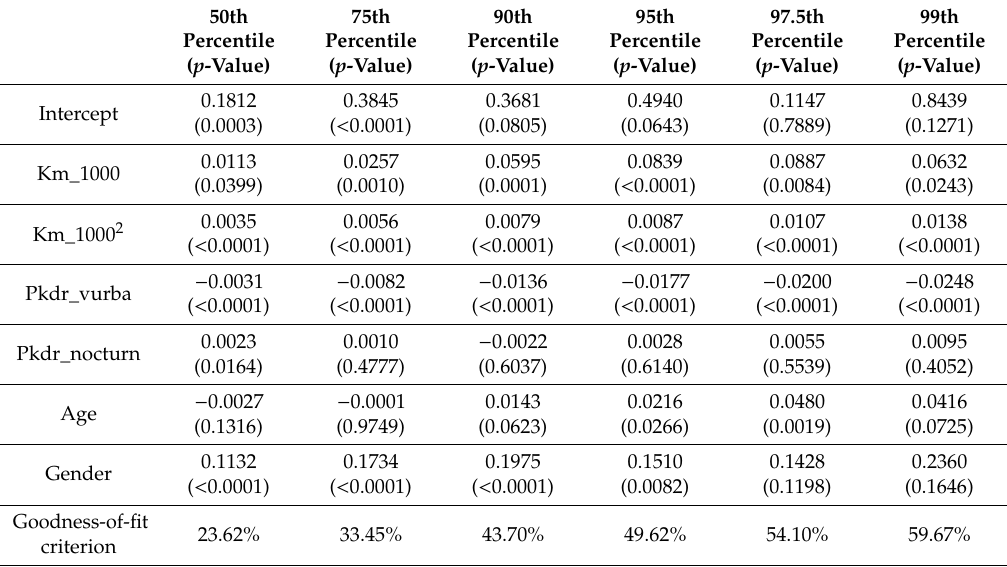
Table A2. Parameter estimates of the quantile regression model for di ff erent percentiles. In that case, Tolerkm / 1000 is the dependent variable and km_1000 (km / 1000) and km_1000 2 are introduced in the model, instead of lnkm, as independent variables.